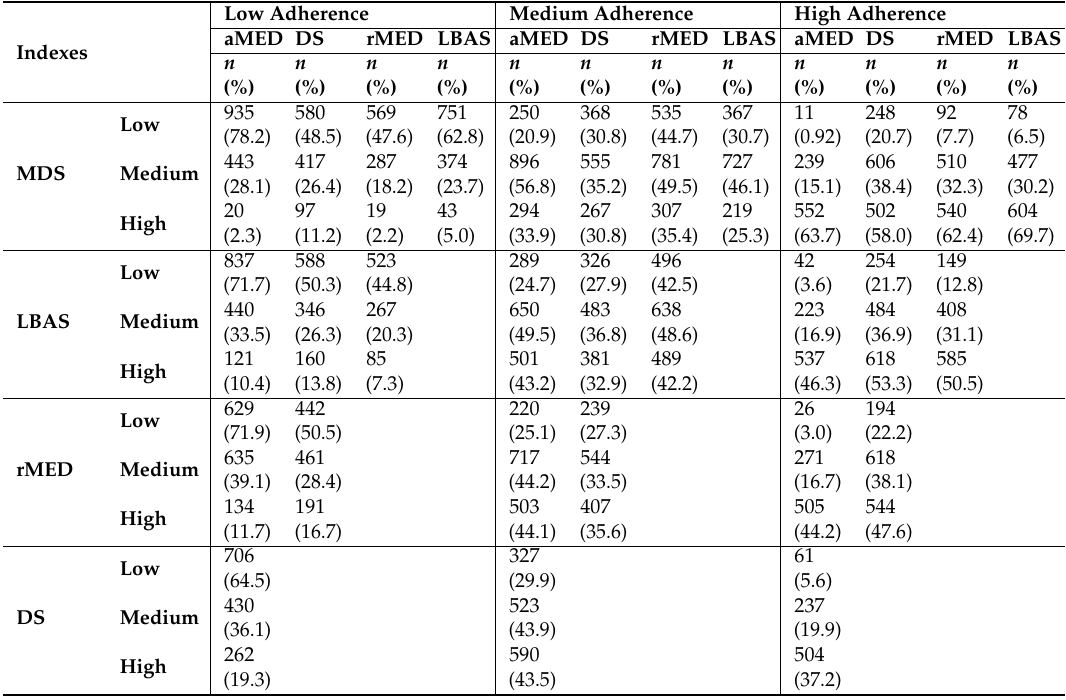
Table 3. Degree of agreement among the adherence to a Mediterranean diet indexes according to the level of adherence: low, medium and high.